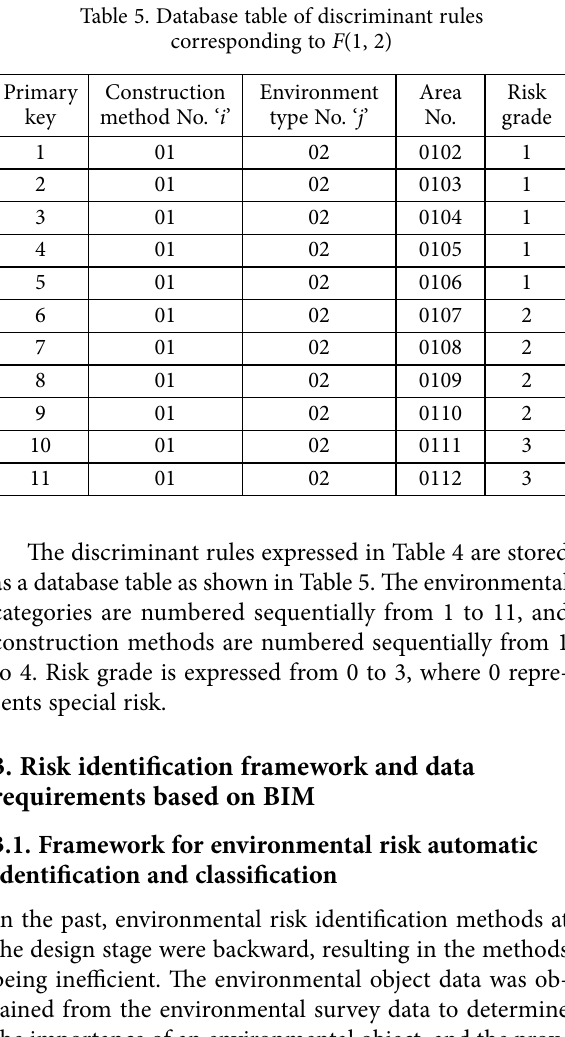
Table 5. Database table of discriminant